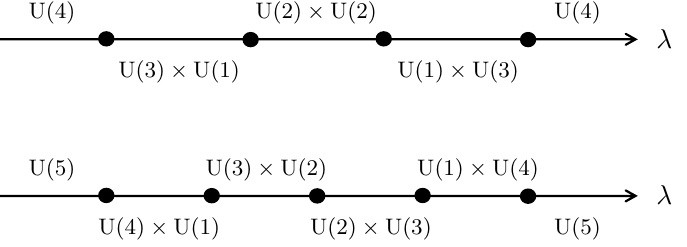
√ g 2 | > π for M = 4 (top) and M = 5 (bottom) e